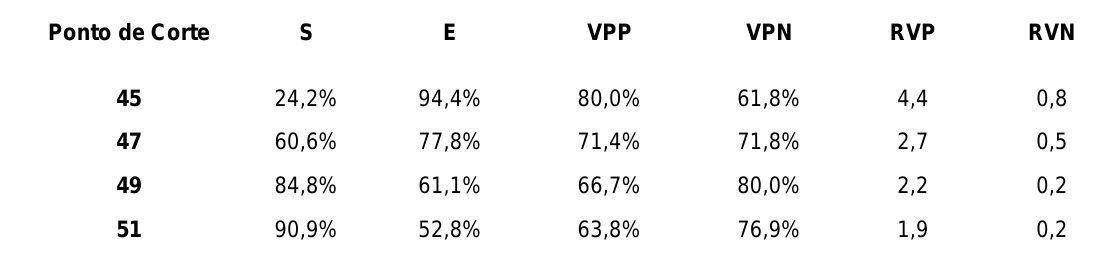
Tabela 5. Sensibilidade, especificidade, valor preditivo positivo, valor preditivo negativo, razão de verossimilhança positiva e razão de verossimilhança negativa referentes aos pontos de cortes da EEB das participantes com osteoartrite de joelho com e sem histórico de